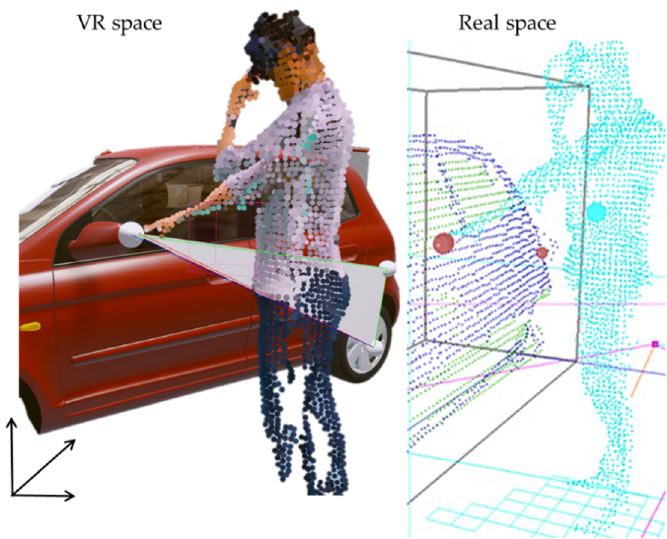
Figure 10. Visualization of a user in VR environment using sample points.